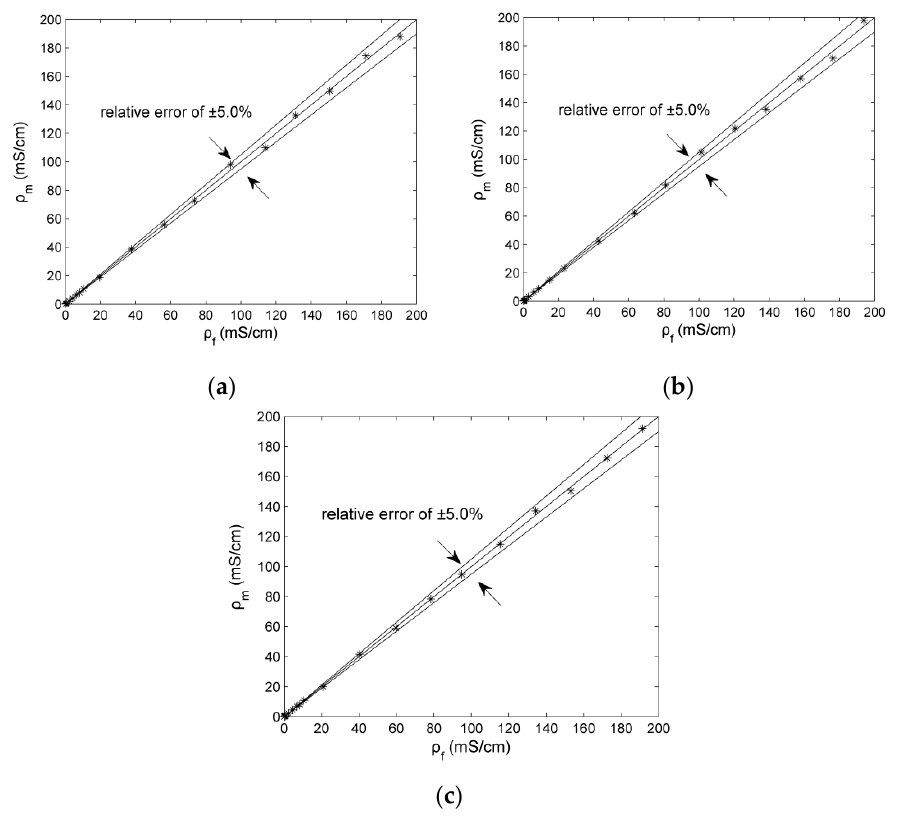
Figure 6. Conductivity measurement results of three new C 4 D sensors: ( a ) 3.0 mm i.d.; ( b ) 4.6 mm i.d.; ( c ) 6.4 mm i.d.